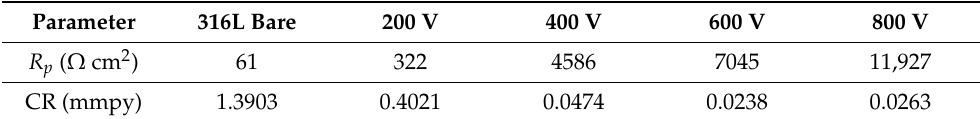
Table 4. Polarization resistance and corrosion rate calculated from potentiodynamic polariza- tion